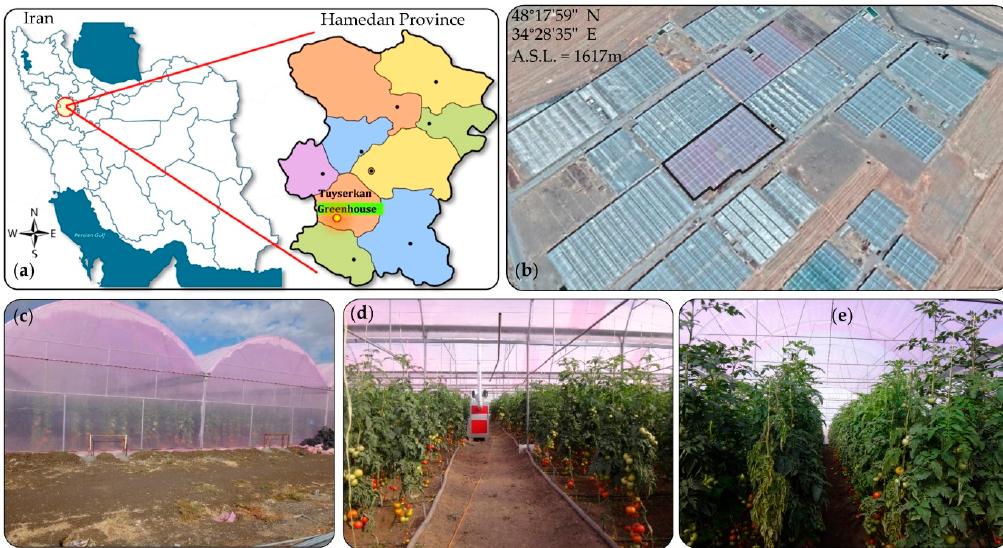
Figure 1. View of the experimental setup showing: ( a ) Locations of the greenhouse in the mid-west of Iran; ( b ) The aerial view of the greenhouse and its orientation; ( c ) outside view of the greenhouse in winter; ( d ) hot air heating system inside the greenhouse; and ( e ) view of tomato rows inside the greenhouse.